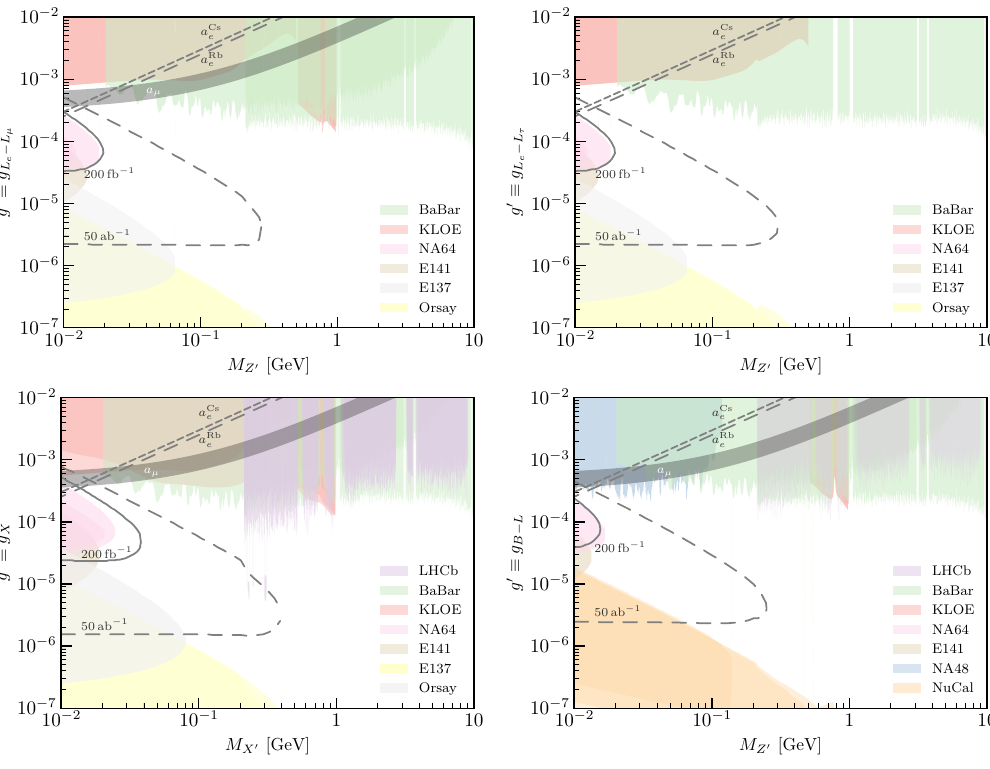
Figure 8 . In the top left and right panels, we plot the projected limits in the parameter space of the L e − L µ and the L e − L τ models respectively. In the bottom left panel and the bottom right panels, we draw the same for the protophobic model and the B − L model